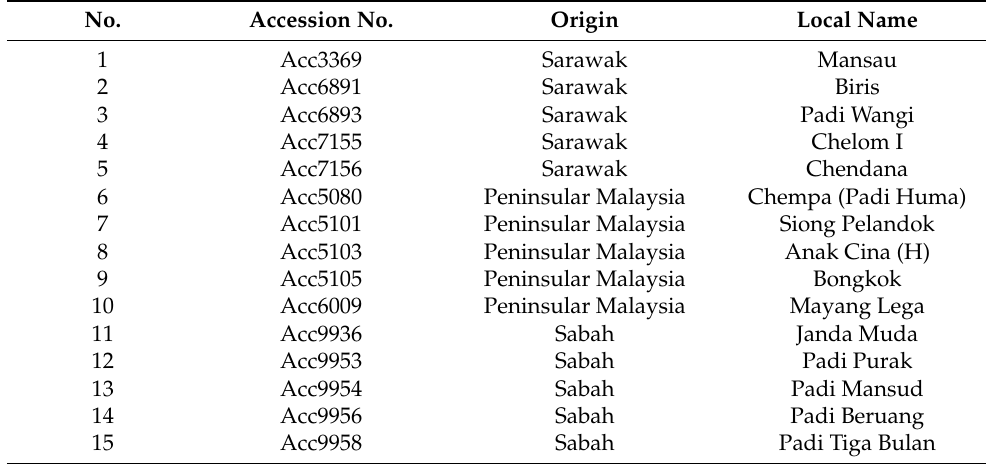
Table 1. Rice varieties.